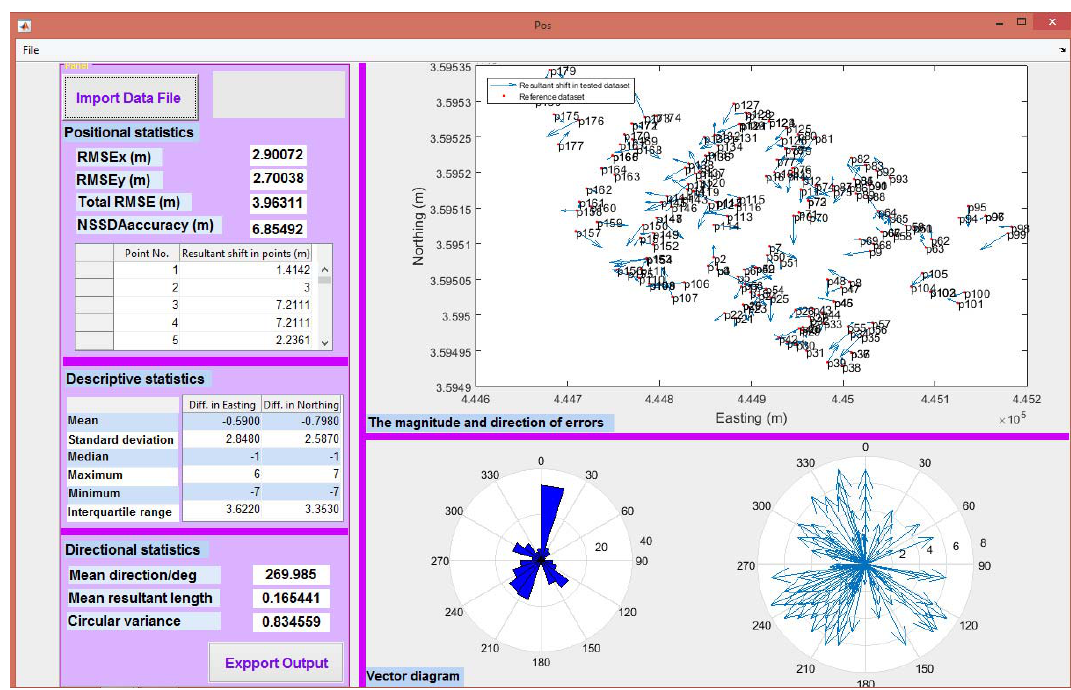
Figure 5. Calculation and visualization tool for RMSE (VGI points captured by GPS, compared to parcel coordinates from official mapping, Moharbeen urban area, Al-Hillah).